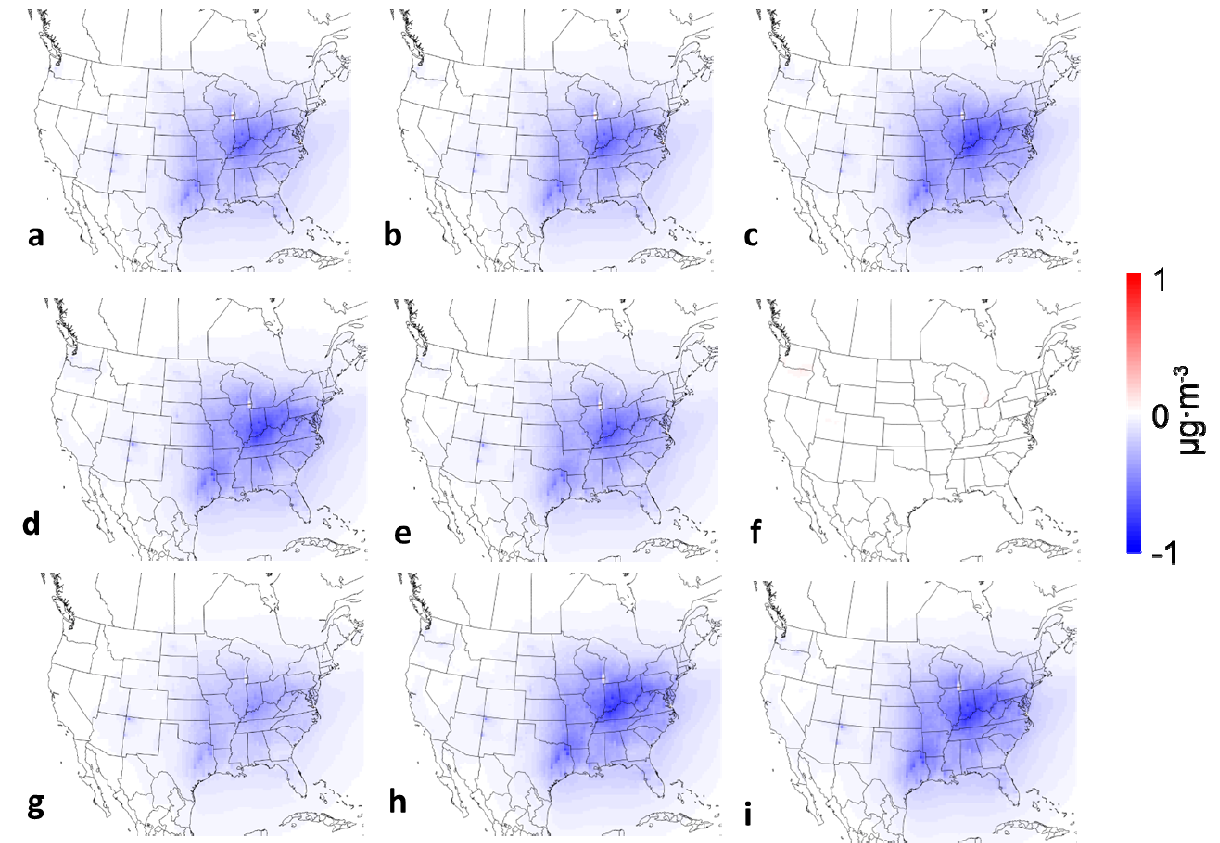
Figure 4. Difference between annual mean PM 2.5 concentrations in μ g m − 3 across the domain for the year 2050 between BAU and: ( a ) CP-25u, ( b ) CP-50u, ( c ) CAP, ( d ) CAP-B, ( e ) CES40, ( f ) ACE, ( g ) CPP20, ( h ) CES50-H and ( i ) CES50-L.